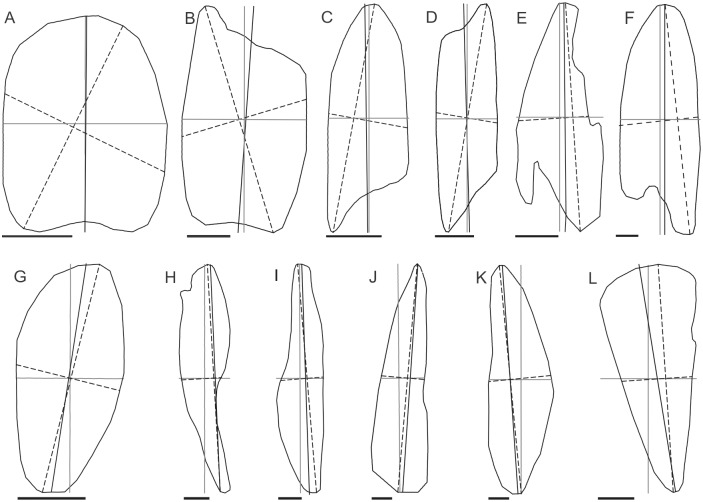
Dependence of the LSL and RLA methods on footprint shape.Examples of Puget Lowland LSB footprints for which the orientation and length of the reference LA is better matched by the RLA than the LSL (A-F), and better matched by the LSL than the RLA (G-L). Grey lines are the minimum bounding rectangle mid-axes; dashed lines represent the LSL and its perpendicular bisector; solid black lines are the reference LA. Bars at the bottom are 100 m long for B and 200 m long for A and C-L.